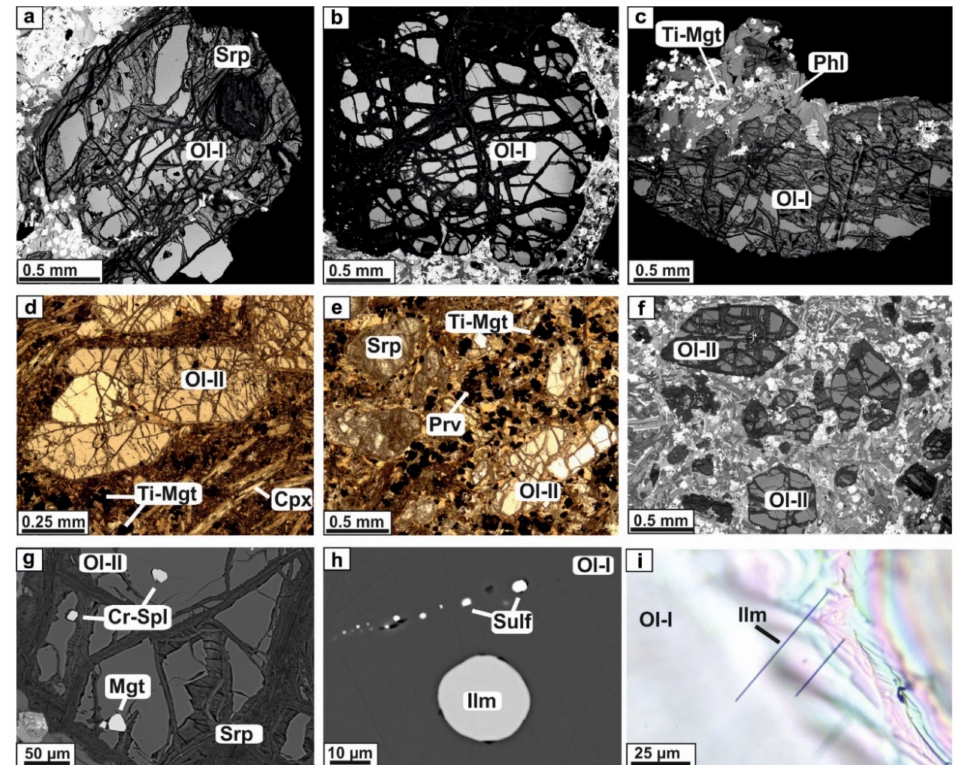
Figure 2. Back-scattered electron (BSE) images ( a – c , f – h ) and microphotographs in transmitted light ( d , e , i ) of olivines from the UMLs of the Terina complex. ( a – c ) Olivine macrocrysts partly replaced by serpentine: ( a , b ) macrocrysts ( G3 ) with reverse zoning, where Mg-rich rims surround more Fe-rich cores; ( c ) a multigranular nodule of olivine with a completely replaced rim. ( d – f ) Euhedral groundmass olivine: ( d ) extremely rare occurrence of unaltered olivine grain in the groundmass; ( e ) practically fresh grains of groundmass olivine coexisting with grains completely replaced by a mixture of serpentine and calcite in a groundmass that consists of phlogopite, apatite, clinopy- roxene, carbonates, Ti-rich magnetite, and perovskite; ( f ) BSE image of a typical aillikite section. ( g – i ) Crystalline inclusions in groundmass olivine ( g ) and olivine macrocrysts ( h , i ): ( g ) fine idiomor- phic spinel grains in groundmass olivine, Cr-spinels in the central part and magnetite in the rim; ( h ) a rounded ilmenite grain entrained during the growth of the olivine macrocryst ( G2 ), and a chain of sulfides inclusions that are secondary to the olivine; ( i ) regular intergrowths of thin ilmenite blades with a high-Fe macrocryst ( G4 ). Cpx—clinopyroxene, Cr-Spl—Cr-rich spinel, Ilm—ilmenite, Ol-I—macrocryst, Ol-II—groundmass olivine, Phl—phlogopite, Sulf—sulfides, Prv—perovskite, Srp—serpentine, Ti-Mgt—Ti-rich